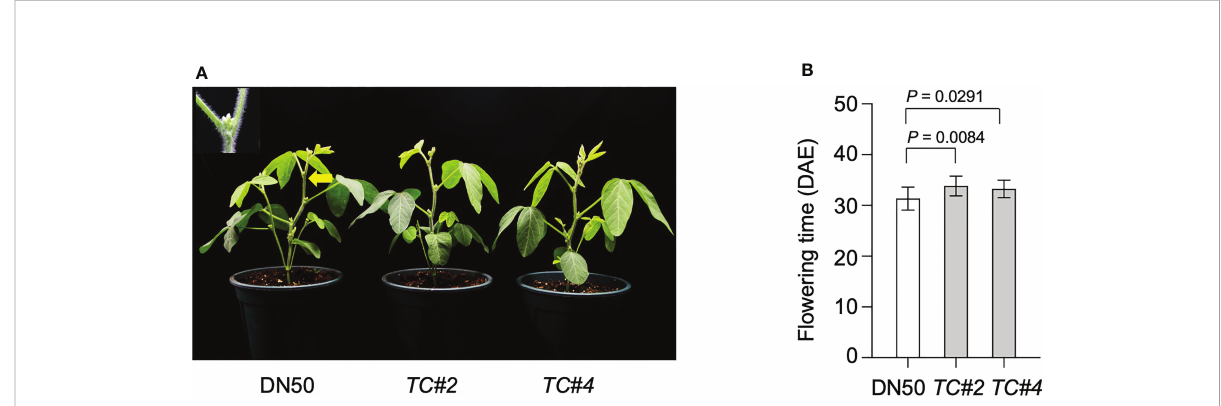
FIGURE 3 Con fi rmed identity of LJ32 by transgenic complementation. (A) The fl owering phenotype of two independent transformants of complementation, TC#2 and TC#4, and the control, DN50 Tof11-1 under SD (12 h light/12 h dark). Scale bar, 10 cm. (B) Flowering time. All data were given as mean ± SD (standard deviation, n = 10 plants). A Student ’ s t-test was used to generate the P